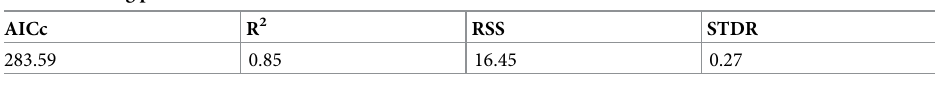
Table 2. Fitting parameters of